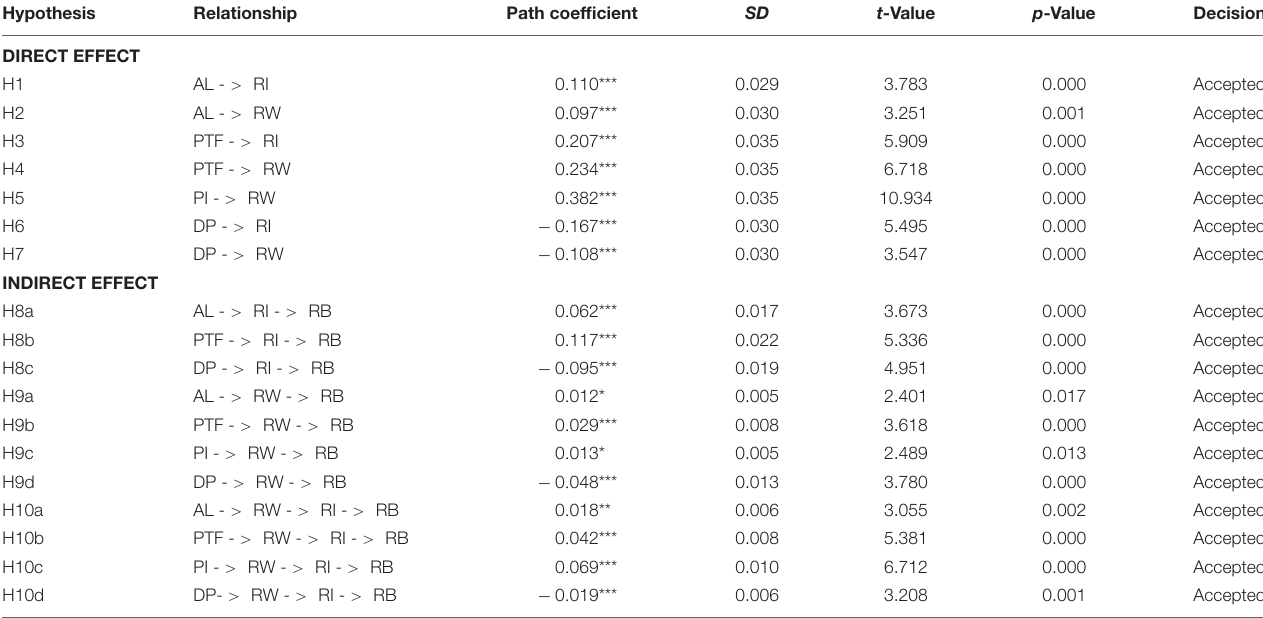
TABLE 6 | Summary of path coefficients and hypothesis